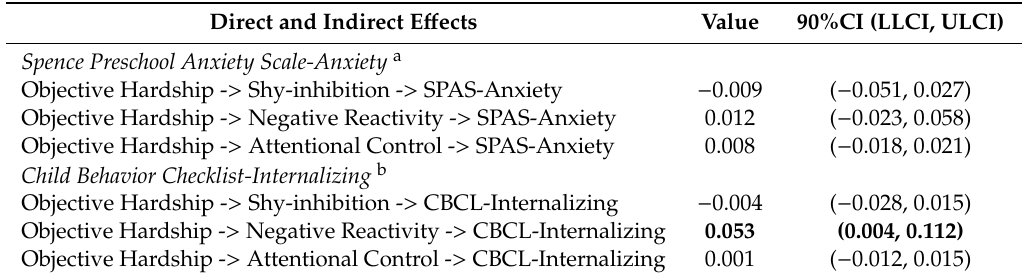
Table 4. Trimmed final models: Standardized indirect effects of prenatal exposure to a natural disaster on maternal report of child anxiety symptomatology.